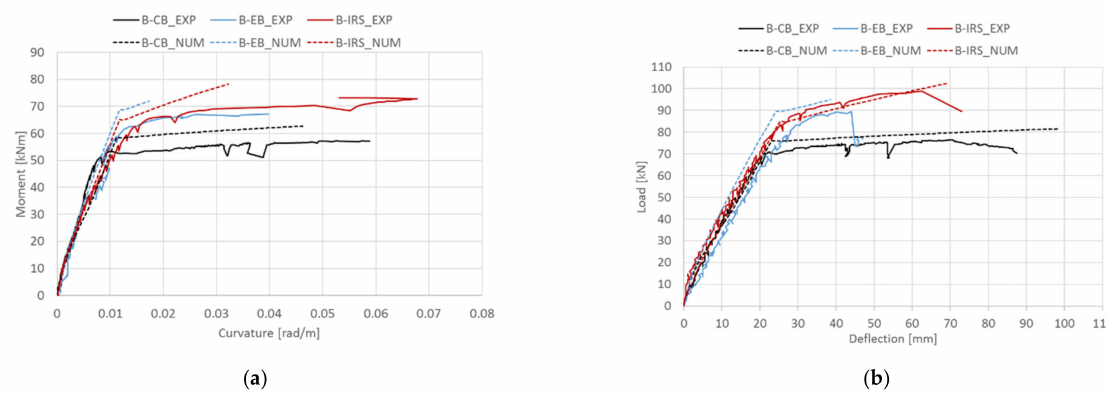
Figure 10. Experimental/theoretical comparisons (group B): ( a ) moment–curvature; ( b ) load–midspan